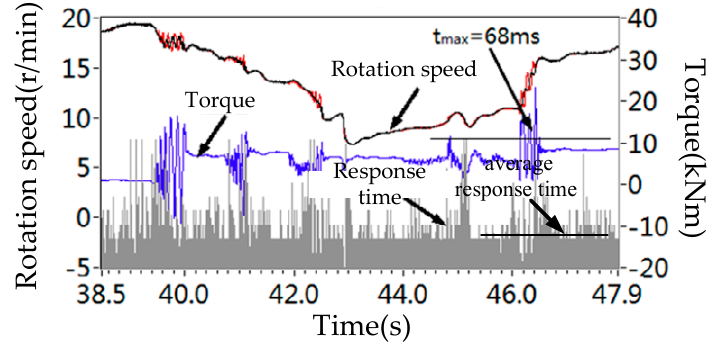
Figure 27. The system response time under the preset path spectrum.